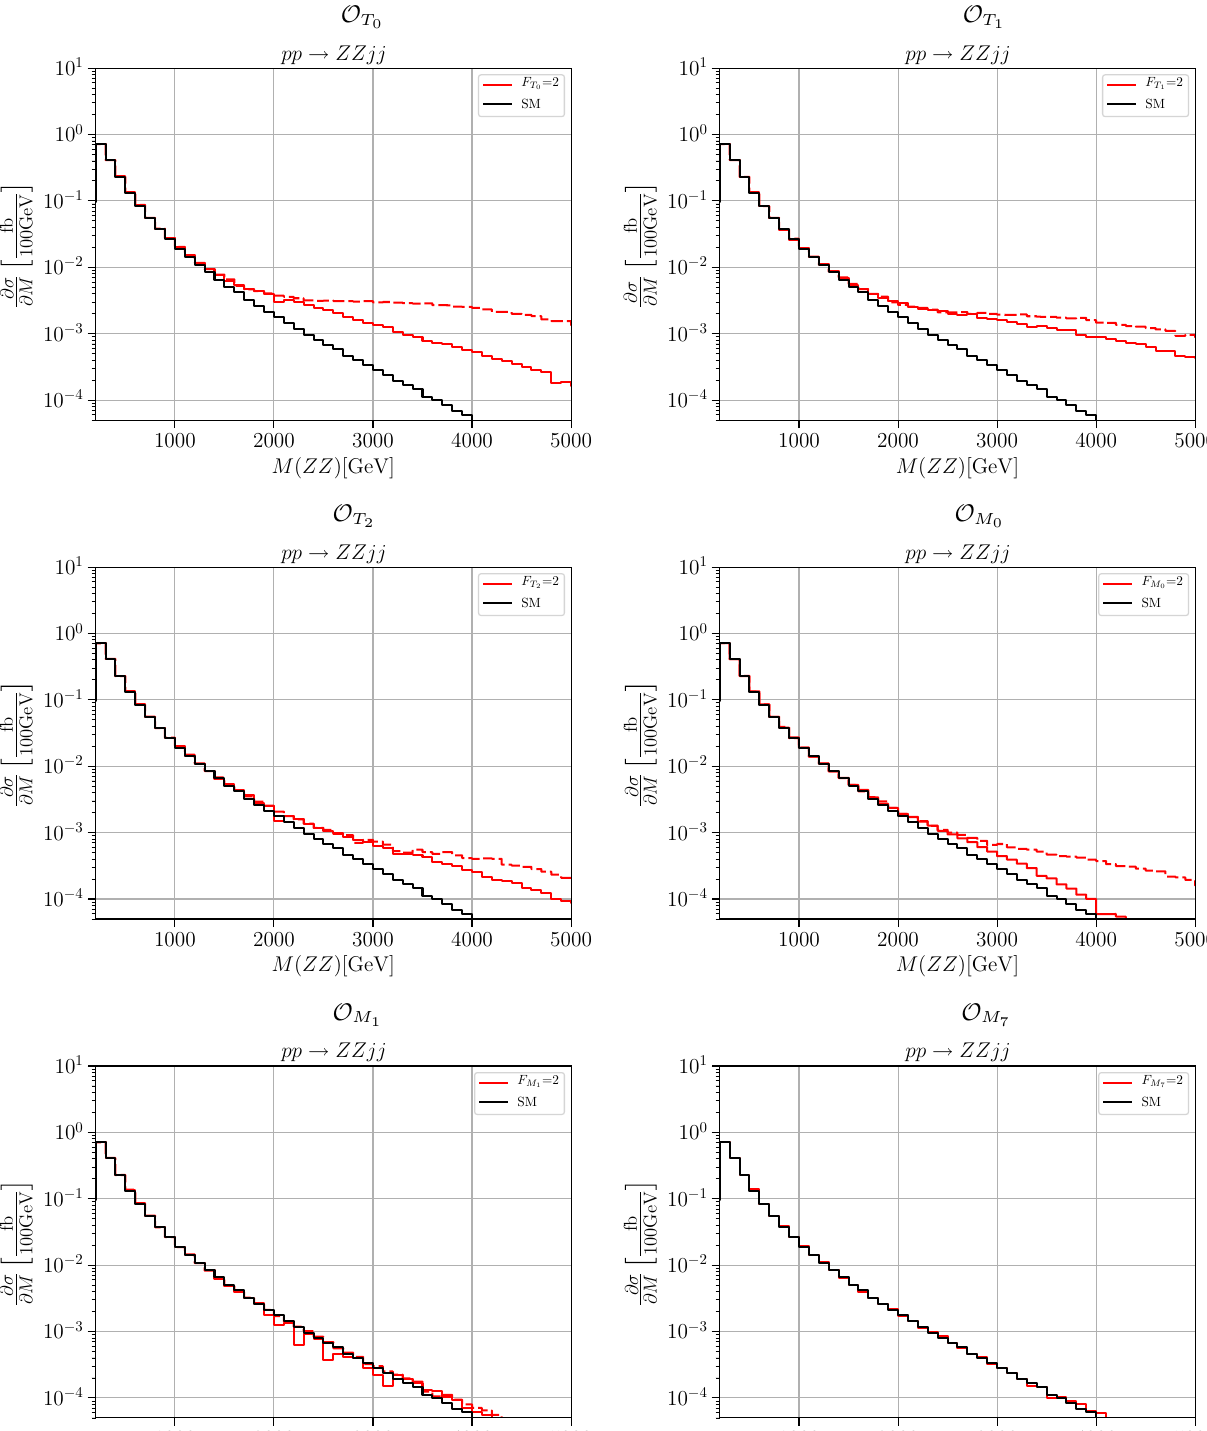
Fig. 7 The plot shows the differential cross section as a function of the invariant mass m VV of the two colliding vector bosons. The solid black line is the standard model and the colored lines are the contributions of